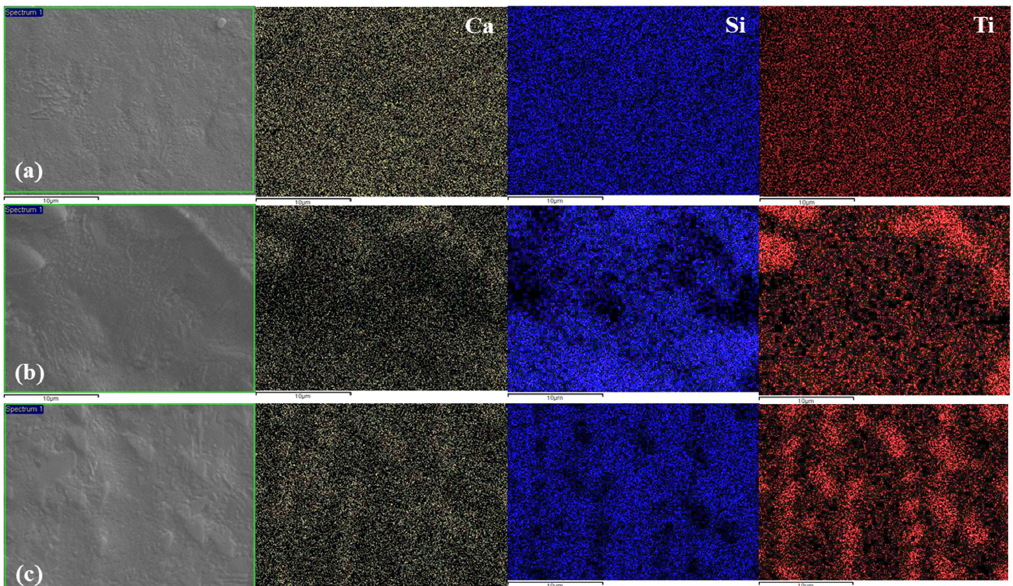
Figure 8. SEM and EDS analyses of glass-ceramics obtained from Ca Glass treated at 960 ºC during (a) 2 hs, (b) 4 hs and (c) 6 hs. Reference bars: 10 μm.